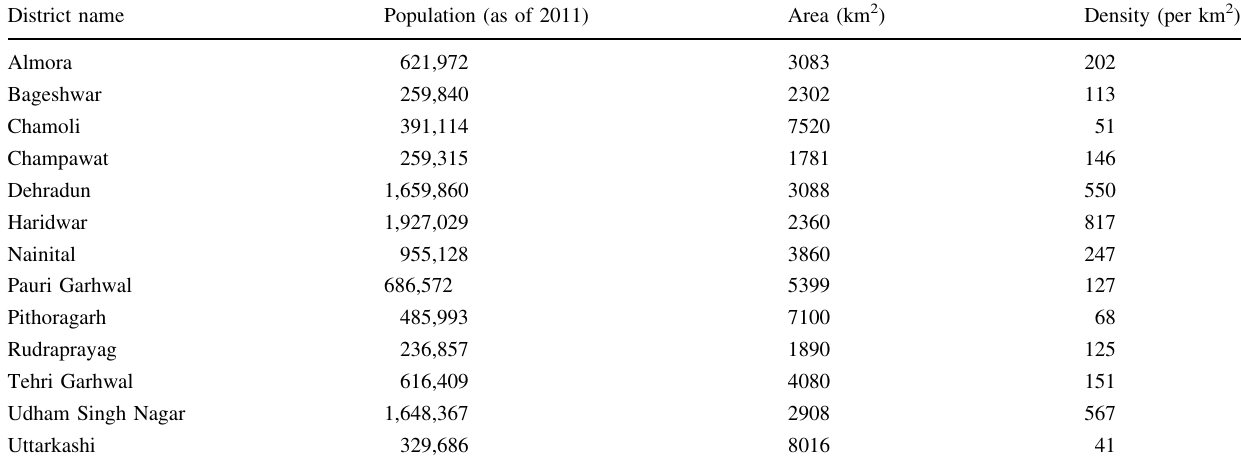
Table 1 Characteristics of Uttarakhand districts District name